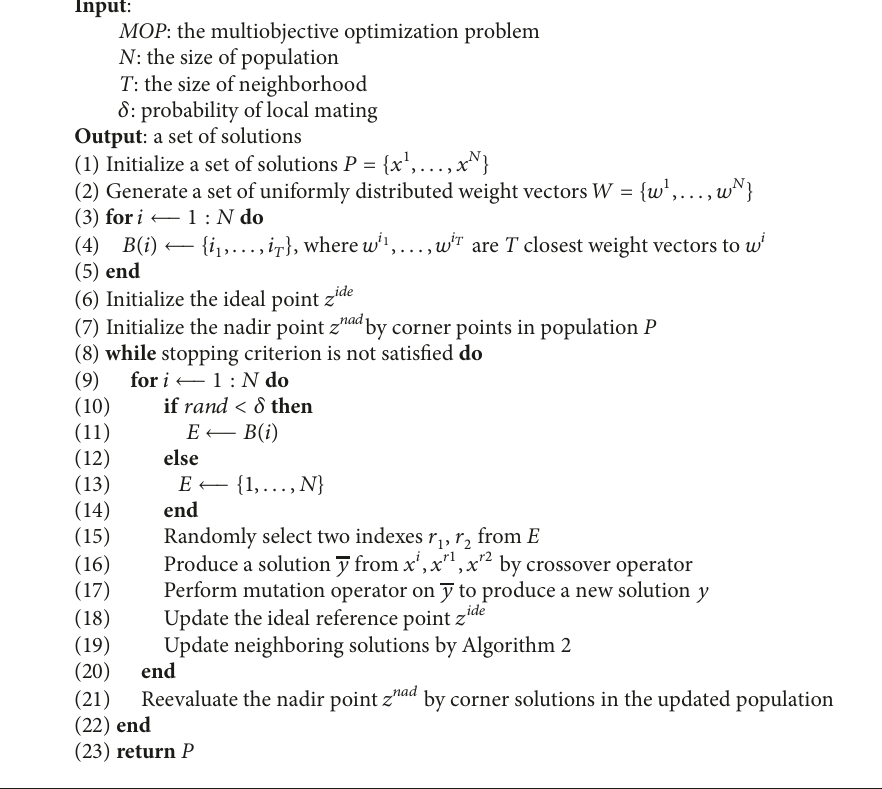
Algorithm 1: Framework of MOEA/D using MUP Method.